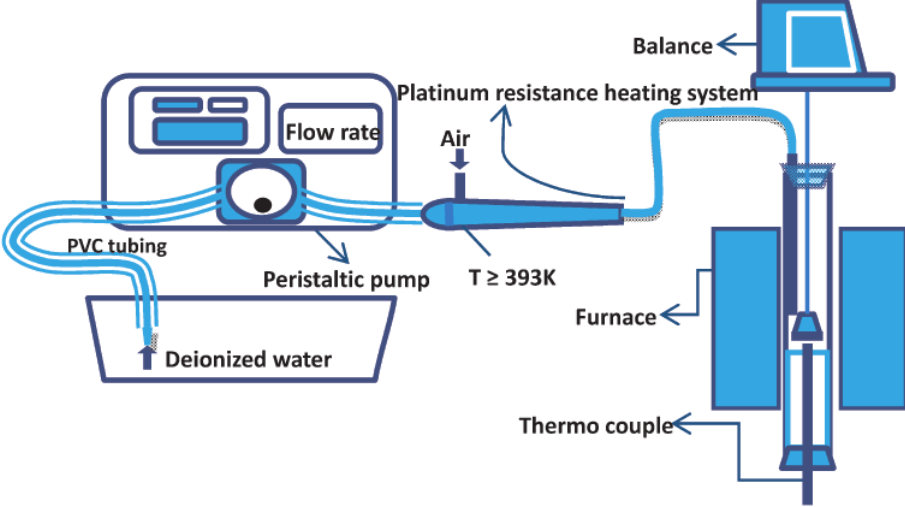
Fig. 1: The schematic of reaction equipment